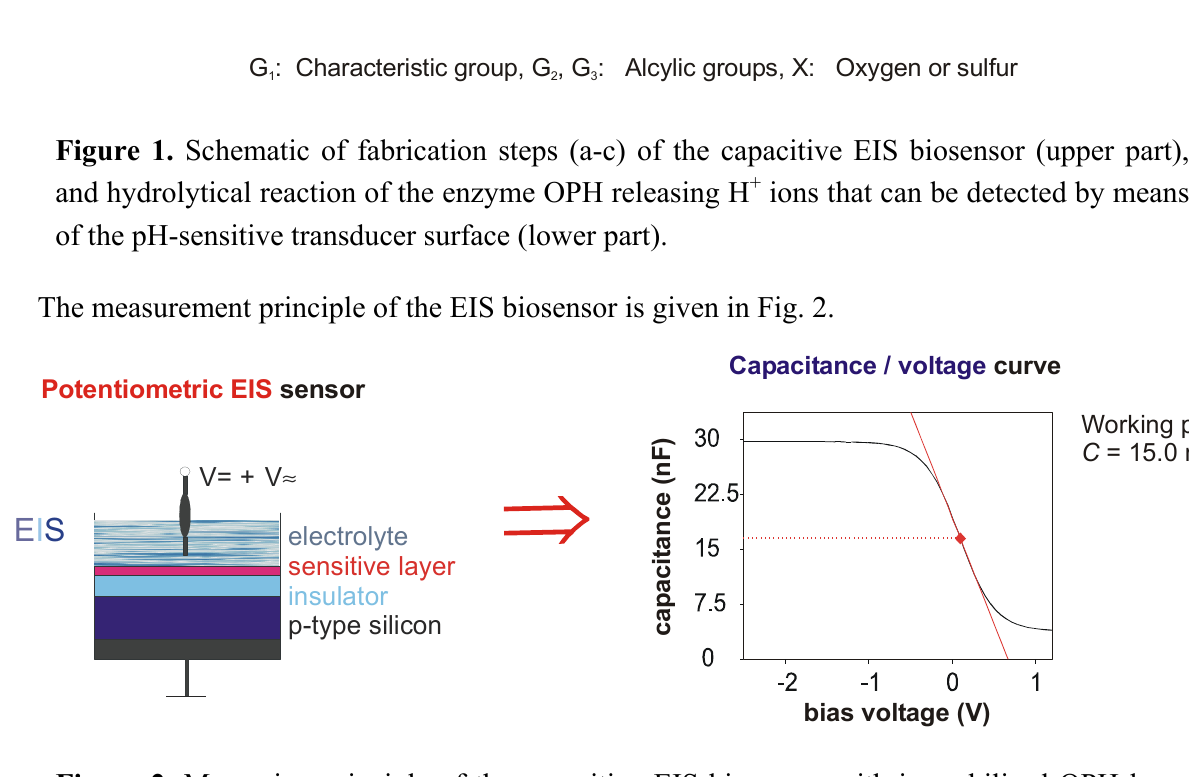
Figure 2. Measuring principle of the capacitive EIS biosensor with immobilised OPH layer (left side), and typical C/V (capacitance/voltage) curve for the determination of the working point of the biosensor (right